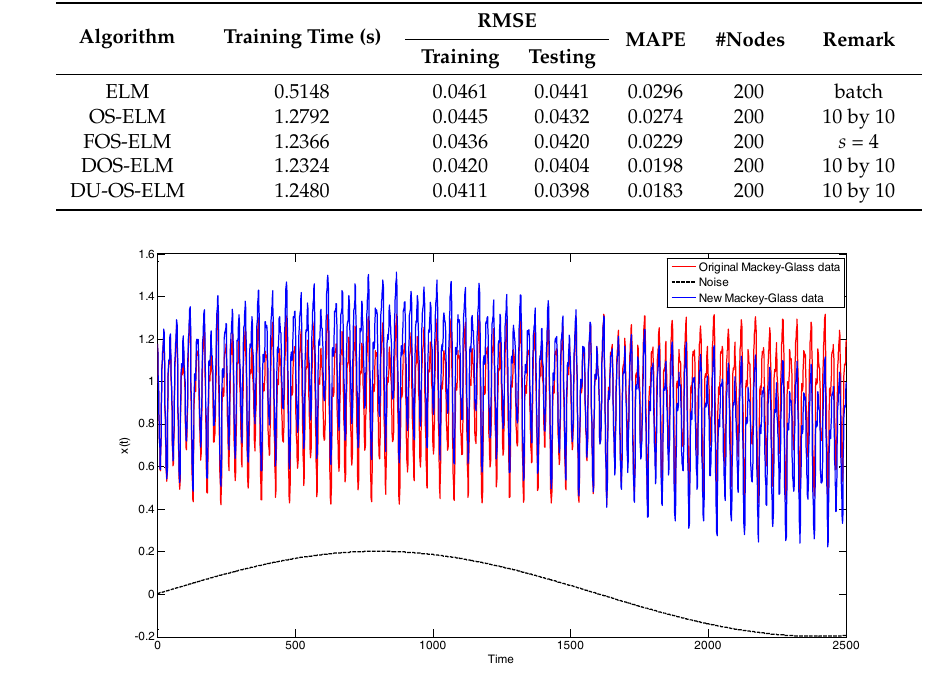
Figure A1. Mackey-Glass chaotic time series.